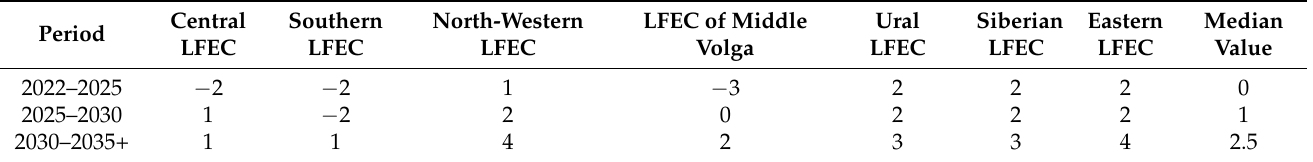
Table 4. Summary of primary and secondary data from the survey for sustainability property (T 1 ) in the gas